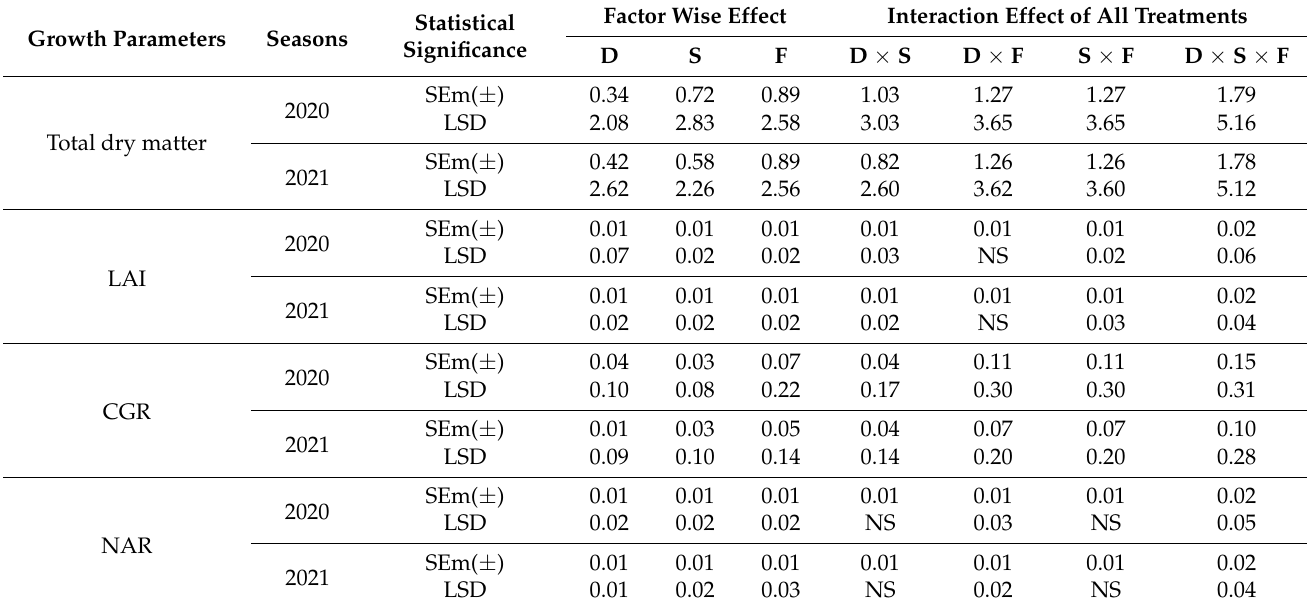
Table 6. Statistical significance and interaction effects of date of sowing, soil application of Co and foliar spray of K and B on the growth traits of black gram during spring–summer season.